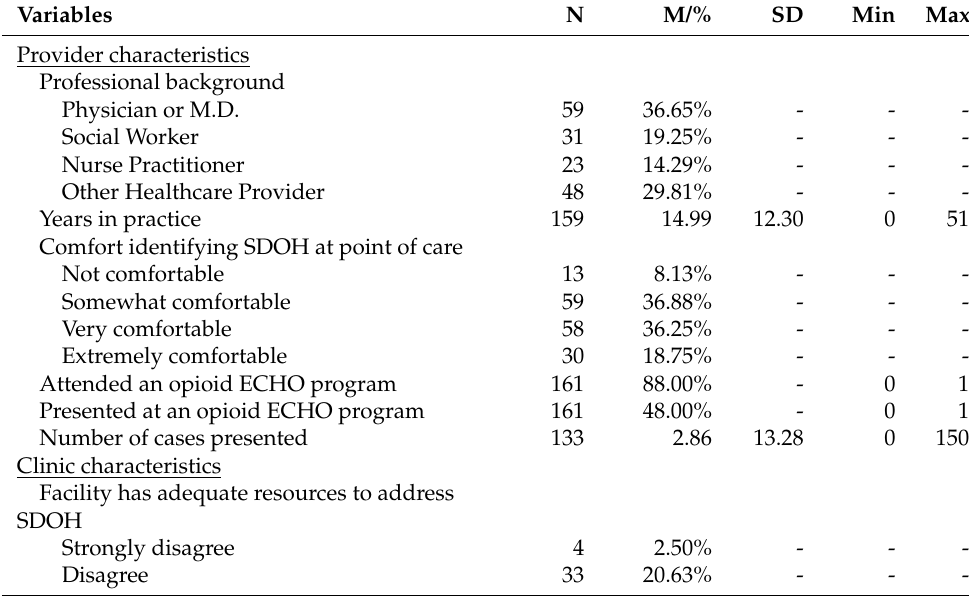
Table 1. Healthcare provider and clinic